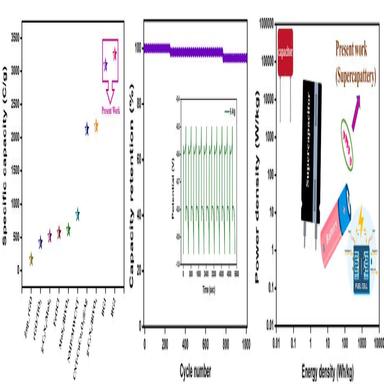
(a) Comparative plot of BG1, BG2 with previously reported supercapattery electrodes (b) Cyclic stability with an insert of first ten GCD cycles and (c) Ragone plot of BG2 supercapattery electrode.